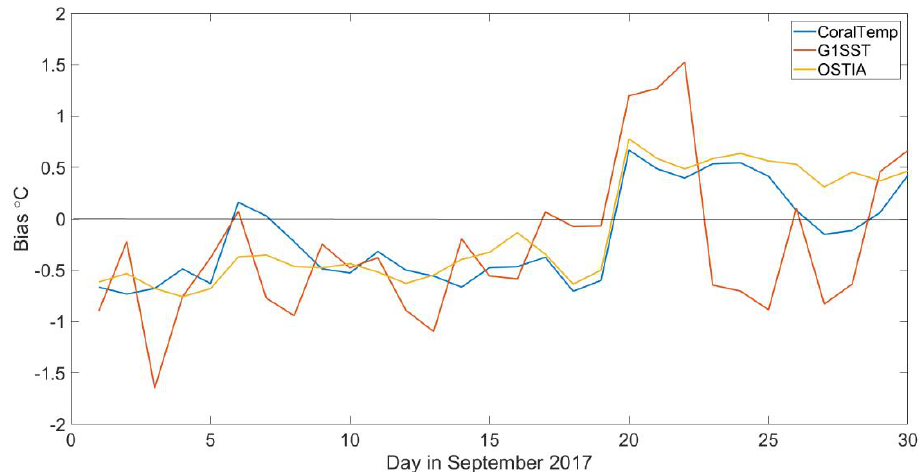
Figure 11. Time series of the bias (satellite—in situ) of the three remote sensing datasets for September 2017. All of the remote sensing datasets displayed a cooler bias, until Hurricane Maria transited the area on 19 September 2017, after which the biases became warm.